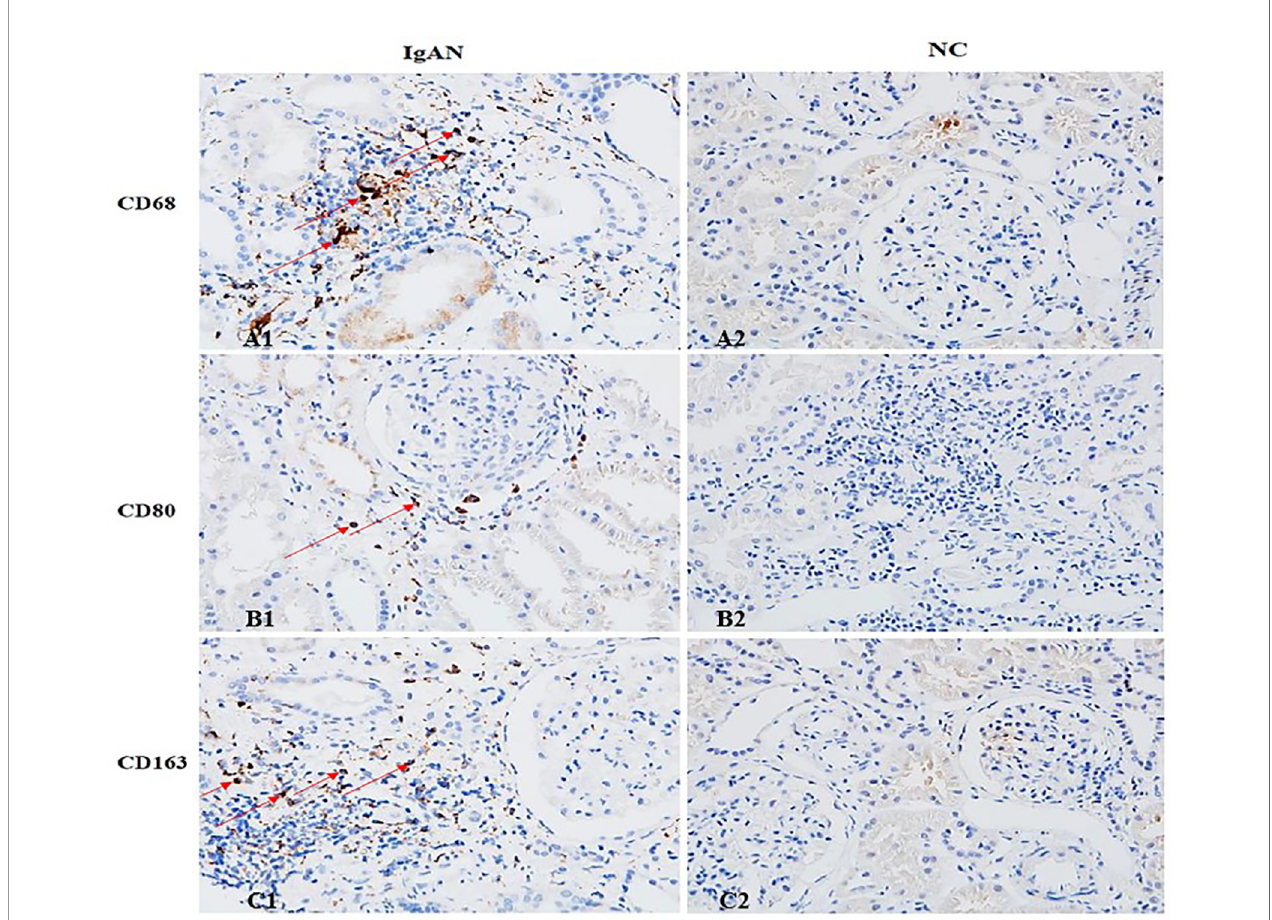
FIGURE 2 | The distribution of different macrophages in the renal interstitium. M0 (CD68), M1 (CD80) and M2 (CD163) macrophages in IgAN group were mainly distributed in the renal interstitium (Cytoplasm brown was the positive macrophage). There were occasional or no macrophages in the interstitium of renal tissue in the NC group. (A1 showed CD68 + cells, B1 showed CD80 + cells, and C1 showed CD163 + cells). (Original magni fi cation×400).